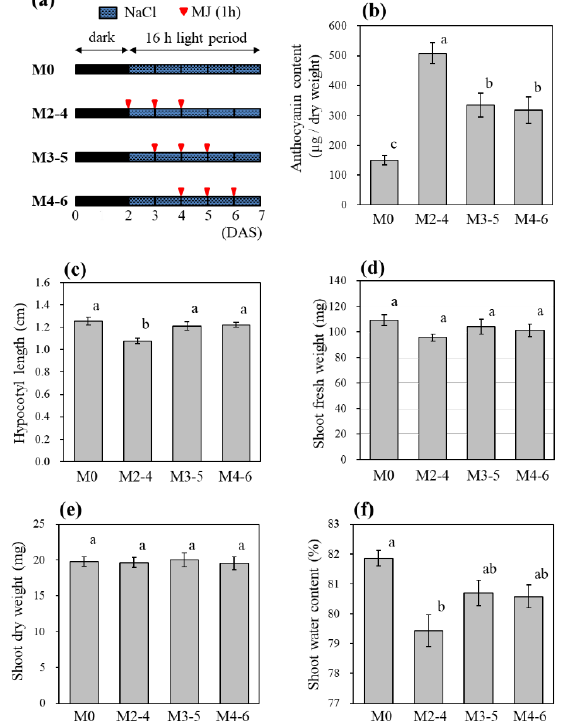
Figure 6. Effect of MJ (0.5 mM) treatment periods on the growth and anthocyanin accumulation in radish sprouts co-treated with salinity (200 mM NaCl). ( a ) Schematic design of this experiment. Anthocyanin concentration ( b ), hypocotyl length ( c ), shoot fresh weight ( d ), shoot dry weight ( e ), and shoot water content ( f ) were measured in sprouts of each treatment at 7 DAS. Error bars represent ± SE ( n = 9). Different letters indicate significant differences by Tukey’s multiple comparison test ( P < 0.05).